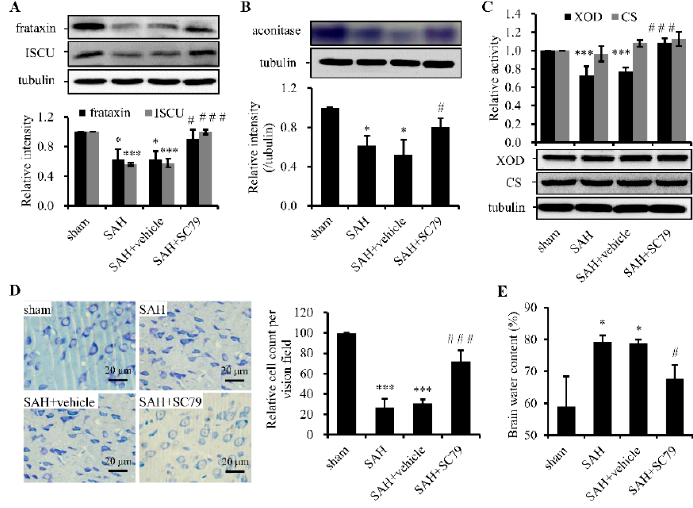
Figure 3. SC79 administration after SAH largely rescues the impairment of Fe-S cluster biogenesis and alleviates the damage of neurons. ( A ) Western blot analysis for frataxin and ISCU. Upper panel: representative protein levels of frataxin and ISCU. Lower panel: quantitative data of the protein levels; ( B ) an in-gel assay of aconitase activity. Upper panel: a representative result. Lower panel: the quantitative data of enzymatic activities; ( C ) enzymatic activity (upper panel) and Western blot (bottom panel) assays of XOD and CS were performed; ( D ) representative slides of Nissl staining (left panel) and quantitative data (right panel) to visualize the neuronal cell outline and structure; snd ( E ) alterations of brain water content. Data are expressed as mean ± SD ( n = 8 in each group). * p < 0.05, *** p < 0.001 vs. the sham group, # p < 0.05, ### p < 0.001 vs. the SAH group. ISCU, Fe-S cluster scaffold protein; XOD, xanthine oxidase; CS, citrate synthase.